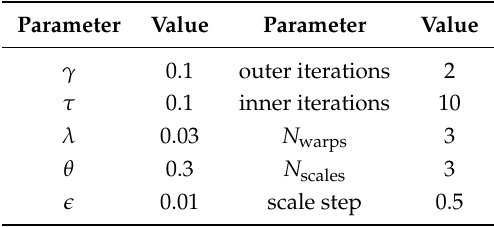
Table 2. List of parameter settings for the TV- L 1 method in the DualTVL1OpticalFlow algorithm by